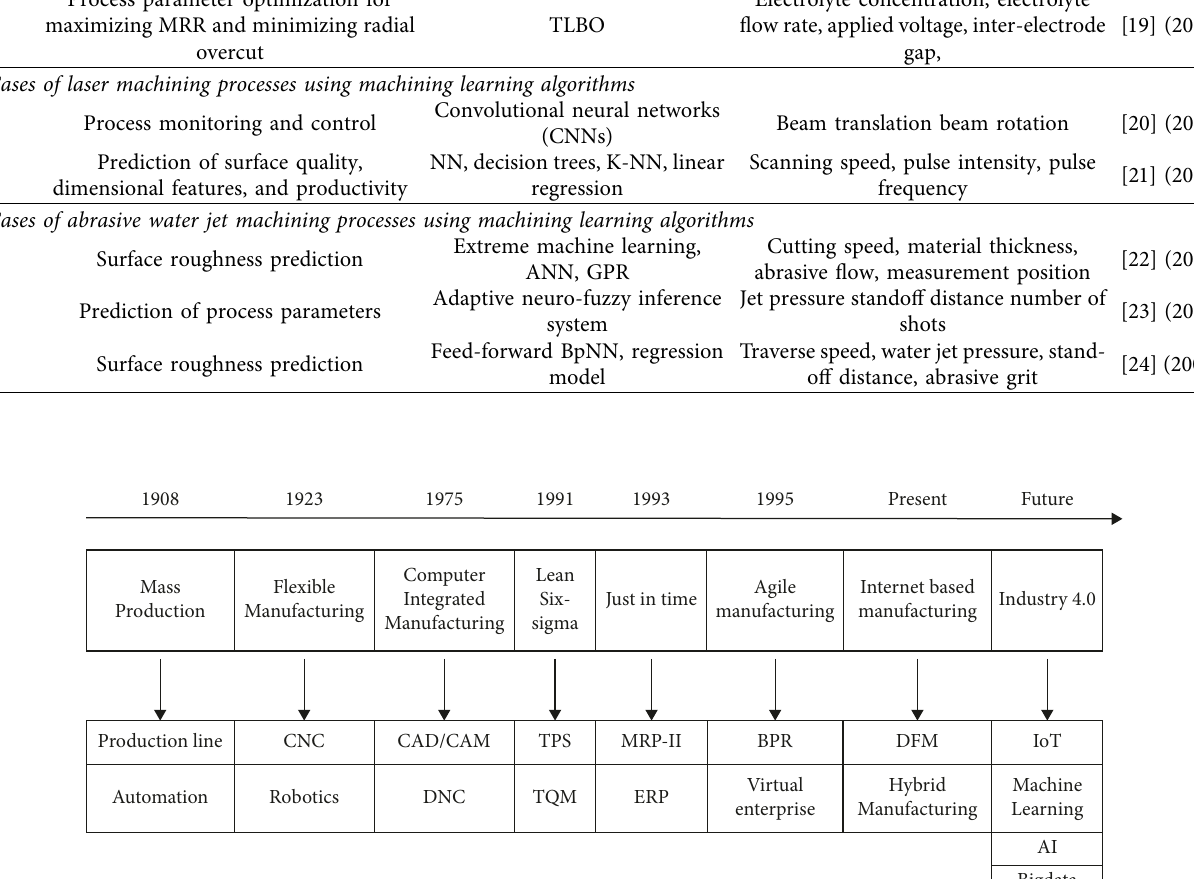
Figure 3: Manufacturing